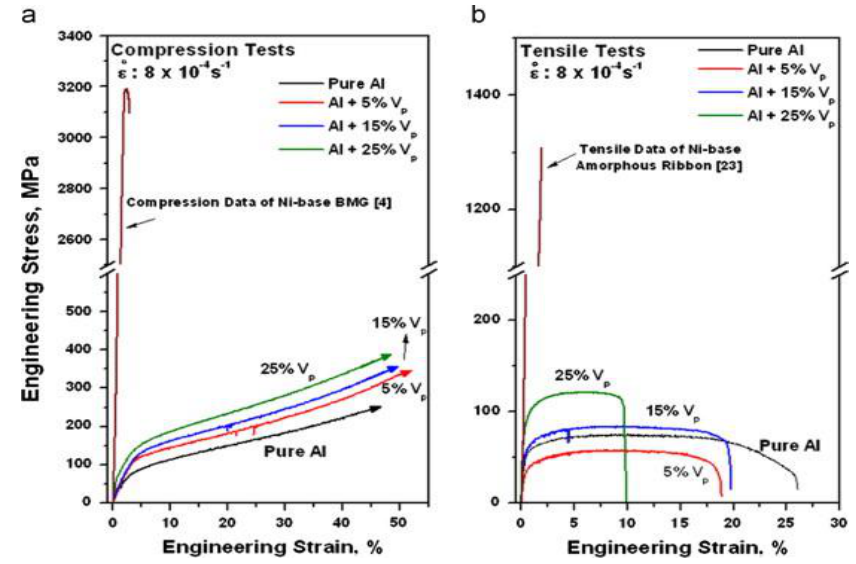
Figure 3. Stress-strain curves of Al-Ni 60 Nb 40 composites under ( a ) compression and ( b ) tension loads (reprinted from Jayalakshmi et al . 2014 [7], with permission from © Elsevier).